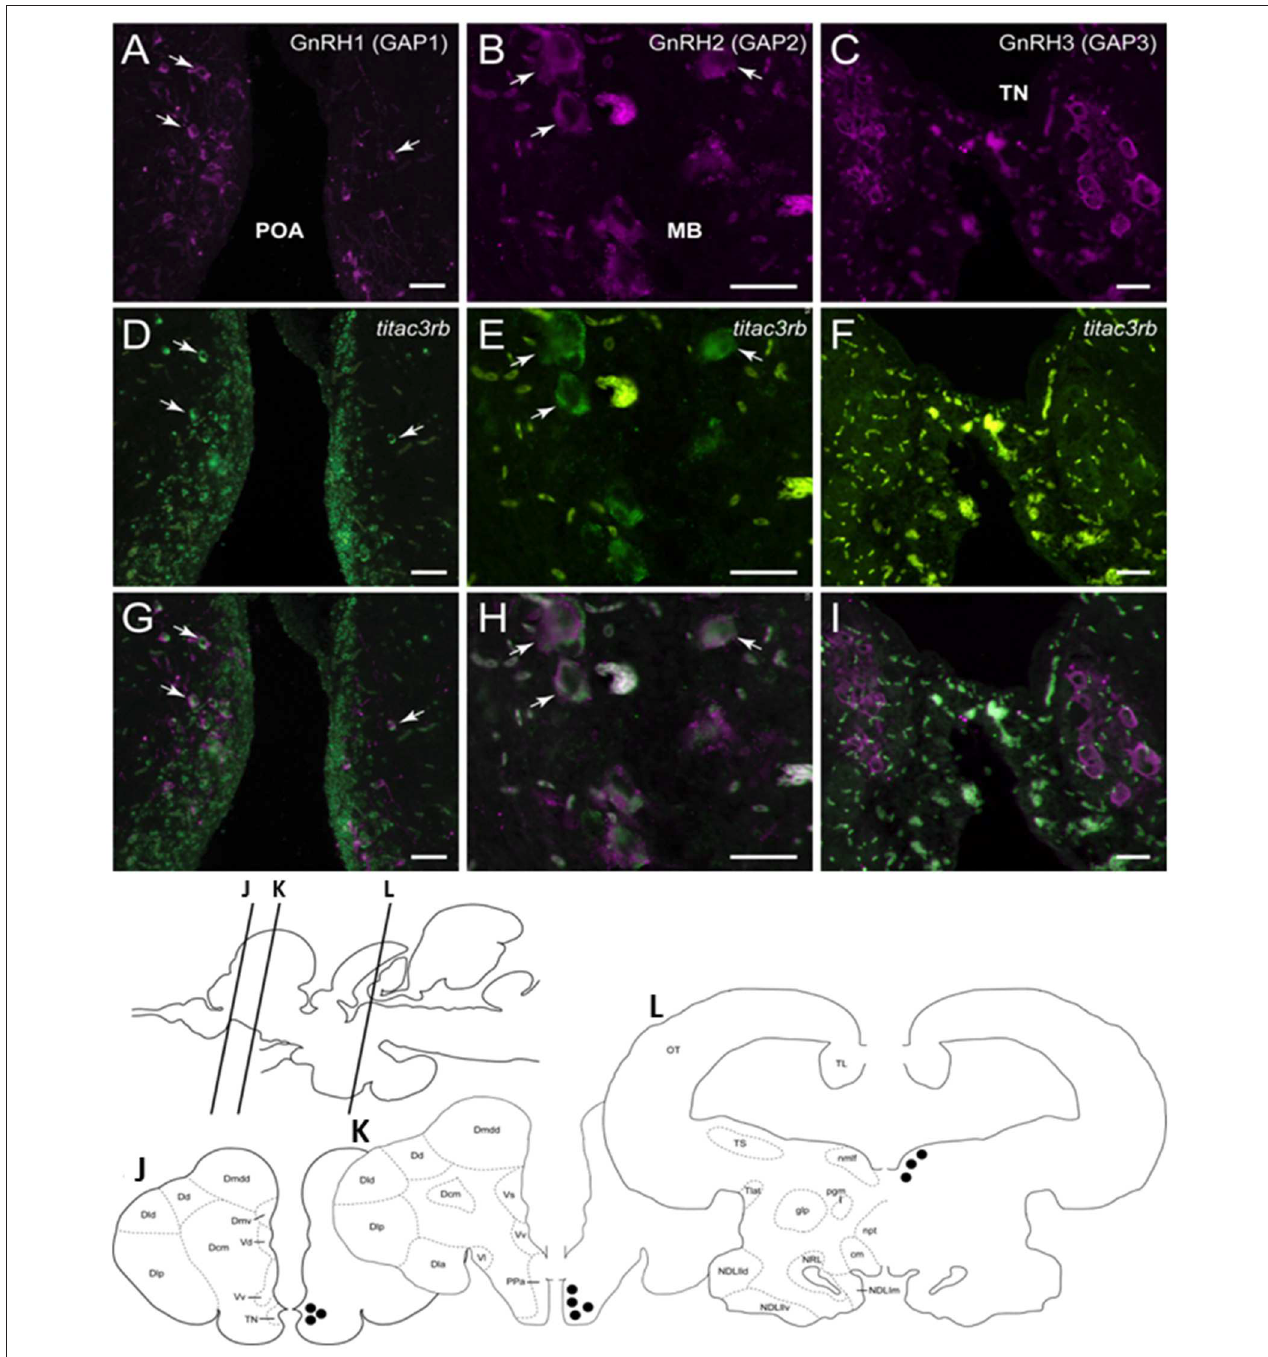
FIGURE 8 | Tilapia tac 3rb is expressed in GnRH1 and GnRH,2 but not in GnRH3, neurons in tilapia brain. Double-labeled ISH-IF of tac 3rb mRNA (green, D,E,F ) and GnRH1 (red, A,D,G ), GnRH2 (red, B,E,H ), and GnRH3 (red, C,F,I ) in the tilapia brain. Scale bar, 50 µ m. Schematic representation of localization of three gonadotropin-releasing hormone (GnRH)-associated peptides (GAP1, GAP2, and GAP3)-immunoreactive (-ir) neurons in the brain of tilapia. Lines on a schematic sagittal drawing view of the tilapia brain indicate levels of transverse brain sections (J–L) shown below. Black dots indicate the location of GnRH1, GnRH2, and GnRH3 (GAP1, GAP2, and GAP3-ir) neurons. GAP3-ir cells in the terminal nerve ganglia at the caudal-most olfactory bulbs (TN, J ); GAP1-ir cells in the anterior part of the parvocellular preoptic nucleus (PPa, K ) and GAP2-ir cells in the midbrain nucleus of the medial longitudinal fasciculus (nmlf, L ). Other abbreviations are listed in the legend of Figure 7